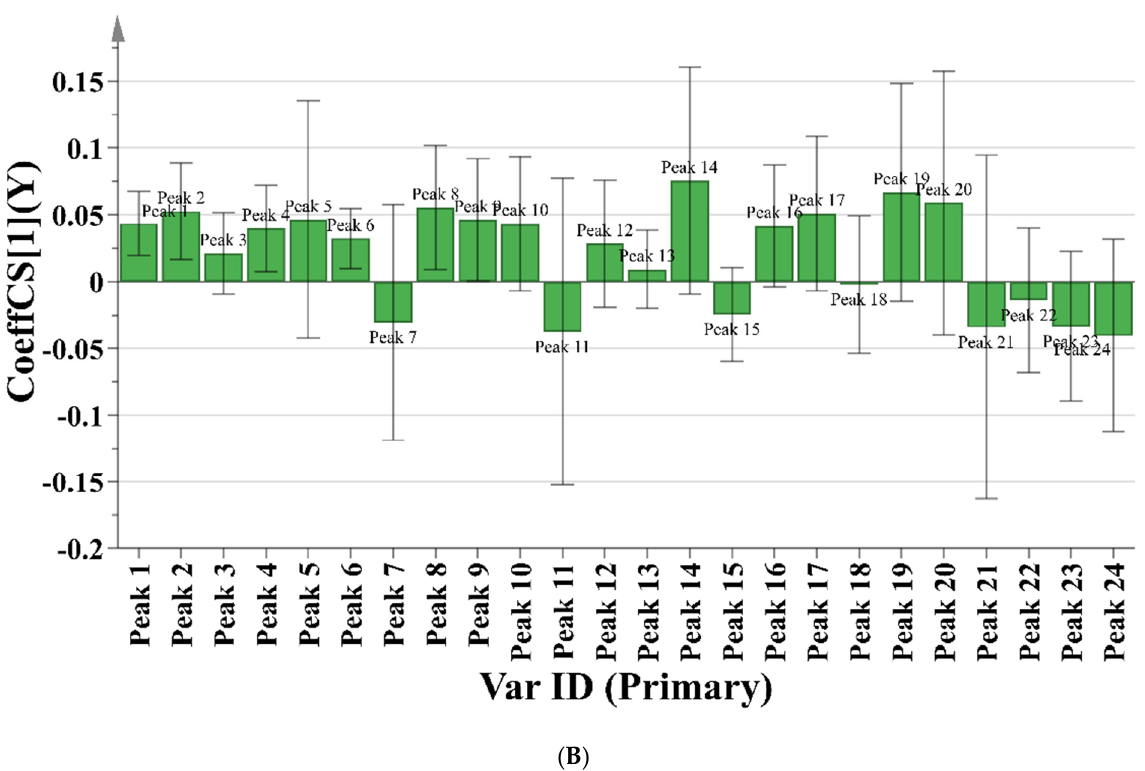
Figure 5. ( A ) Correlation coefficient of 24 chromatographic peaks with antioxidant capacity from FRAP assay; ( B ) Correlation coefficient of 24 chromatographic peaks with antioxidant capacity from ABTS assay.